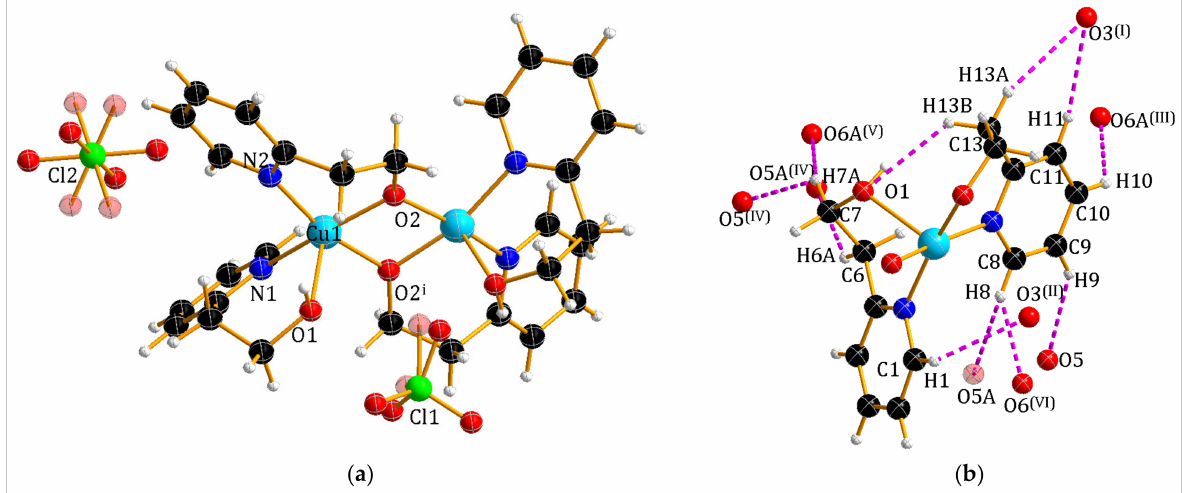
Figure 3. ( a ) Perspective view of the molecular structure of [Cu 2 (2-(HOCH 2 CH 2 )py) 2 (2-(OCH 2 CH 2 )py) 2 ](ClO 4 ) 2 ( 3 ) ((i) − x + 1, y, − z + 1 ) and ( b ) the C-H ··· O interactions in the asymmetric unit of complex 3 2